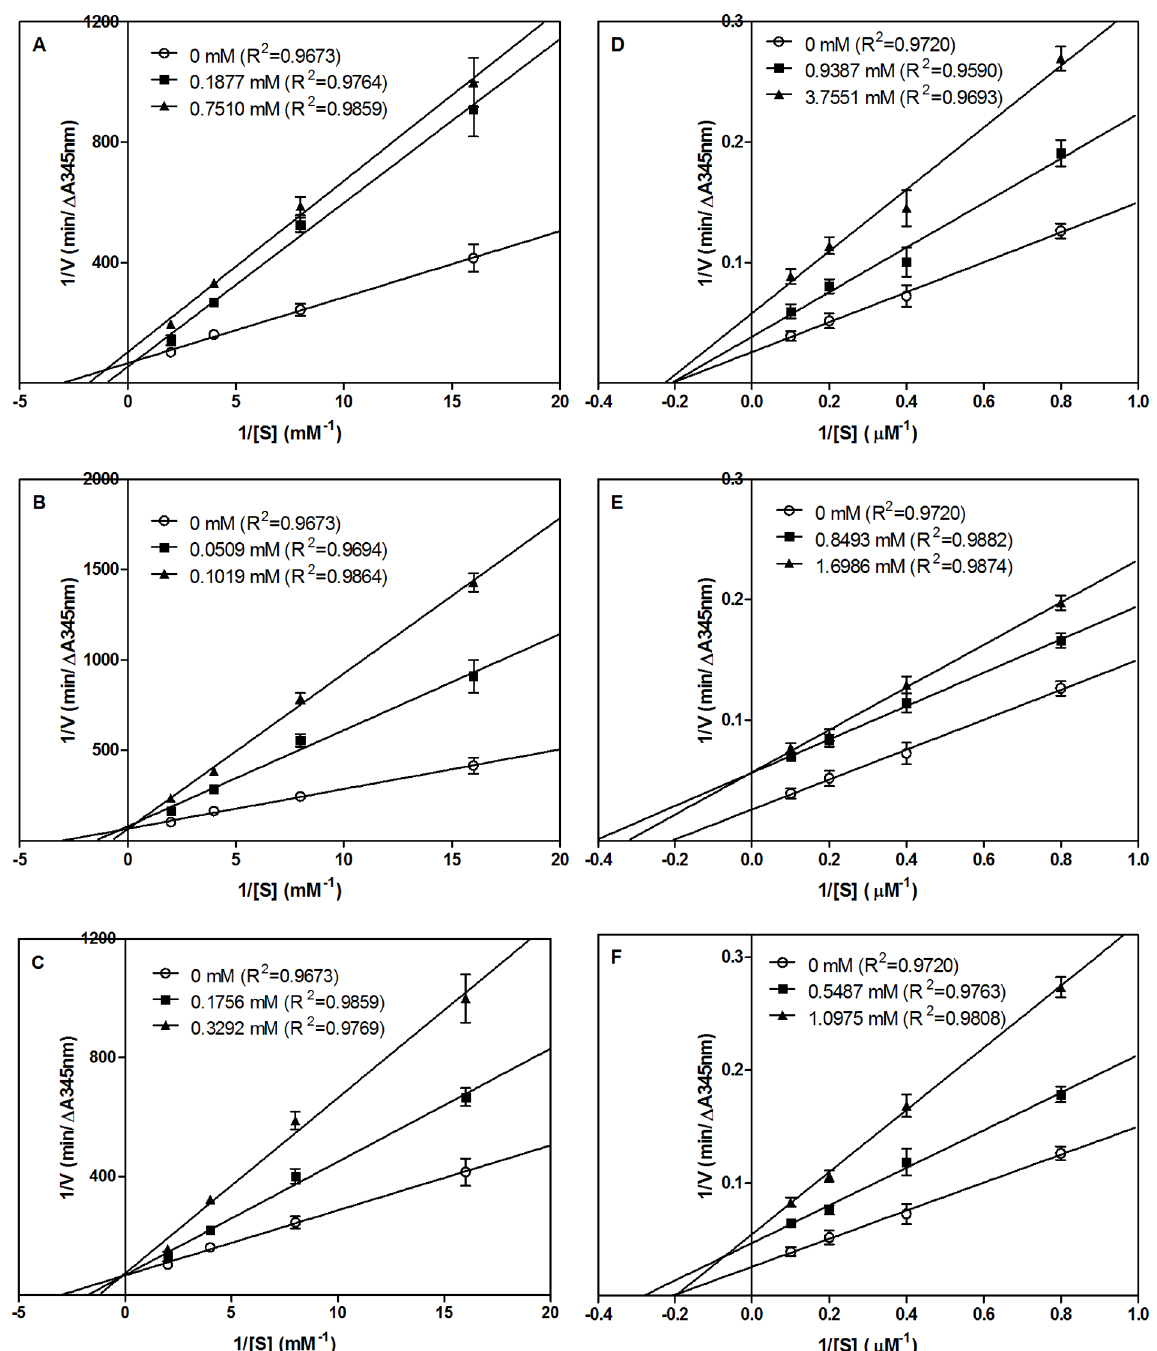
Figure 1. Lineweaver-Burk plots of the inhibition of ACE and renin by peptides. (A) TF, (B) LY, and (C) RALP are at varying concentrations of ACE substrate (0.0625–0.5 mM), and V is rate of reaction ( D A345 nm/min); (D) TF, (E) LY and (F) RALP are at varying concentrations of renin substrate (1.25–10 m M), and V is rate of reaction (FIU/min). doi:10.1371/journal.pone.0091051.g001 2.5 and energy was minimized with the CHARMm program. For partial flexibility CDOCKER tool of the DS 2.5 software in the presence of cofactors (zinc and chloride ions). For renin docking, a crystal structure of human renin (2V0Z) bound to aliskiren (renin- inhibitory drug) was used. Aliskiren and all the water molecules present in the renin structure (except H 2 O-184 and H 2 O-250) were removed and hydrogen atoms added. A binding site with